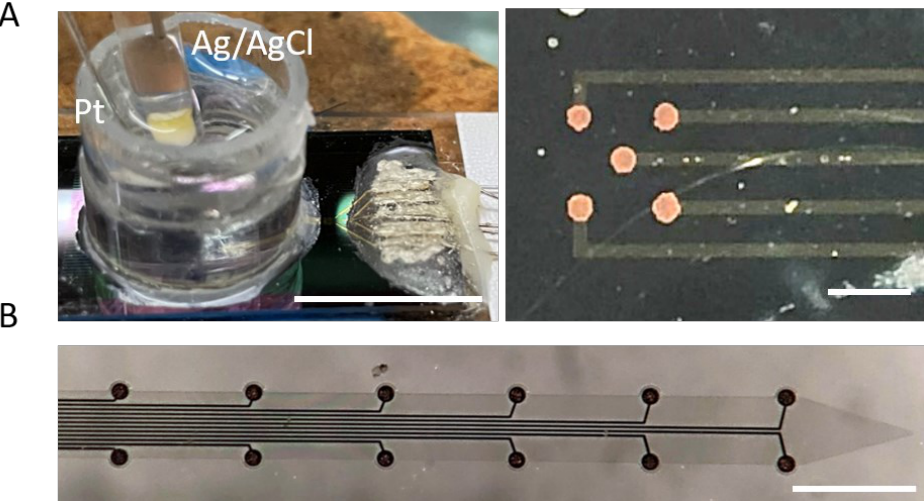
Figure 1. Optical images of the in vitro and in vivo MEAs. ( A ) In vitro silicon MEA chip assembly. Left: A 1 mL cloning ring was glued on the silicon MEA chip enclosing the microelectrode sites. Stainless-steel wires and silver paste were used for connecting the contact pads of the MEA chip to the potentiostat. The electrochemical cell was set up with a Pt counter electrode and Ag/AgCl reference, scale bar = 0.5 cm. Right: the 5 microelectrode sites are distributed in the 4 corners and the center of a 300 × 300 µm square. Scale bar = 300 µm. ( B ) Flexible SU-8 thin film MEA for in vivo experiments. 12 Au sites (35 µm diameter) with a spacing of 300 µm are distributed along both edges of the shank. Scale bar 300 µm.